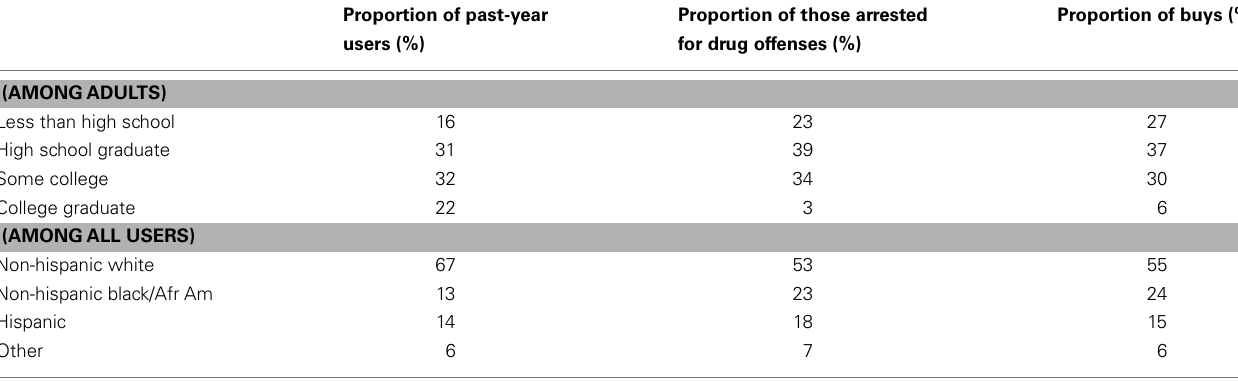
Table 2 | Past-year use, number of drug-related arrests, and number of monthly purchases by education level and racial-ethnic group, 2011